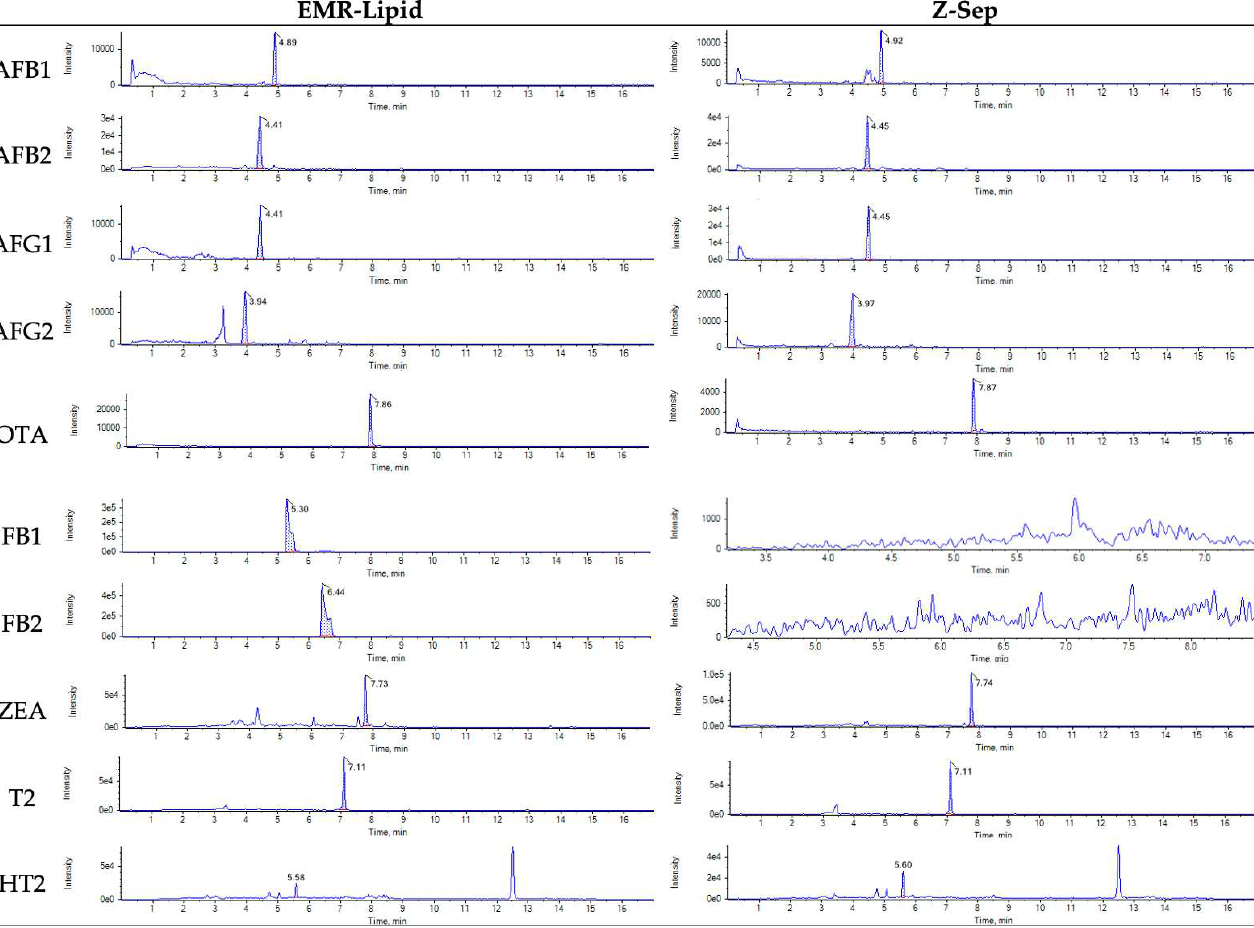
Figure 6. Chromatograms of blank pistachio sample spiked with 2 μg/kg of Aflatoxin B1 (AFB1), 4 μg/kg of Aflatoxin B2 (AFB2), Aflatoxin G1 (AFG1) and Aflatoxin G2 (AFG2), 3 μg/kg of Ochratoxin A (OTA), and 200 μg/kg of Fumonisin B1 (FB1), Fumonisin B2 (FB2), Zearalenone (ZEA), toxin T2 (T2) and toxin HT-2 (HT2), with enhanced matrix removal-lipid (EMR-lipid) and zirconium oxide (Z-Sep) sorbents in dispersive solid-phase extraction (d-SPE) clean-up.